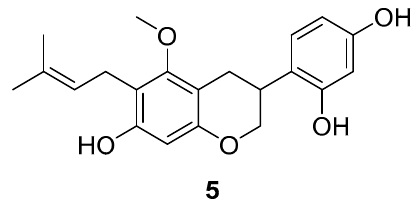
Figure 5. Dehydroglyasperin ( 5 ).